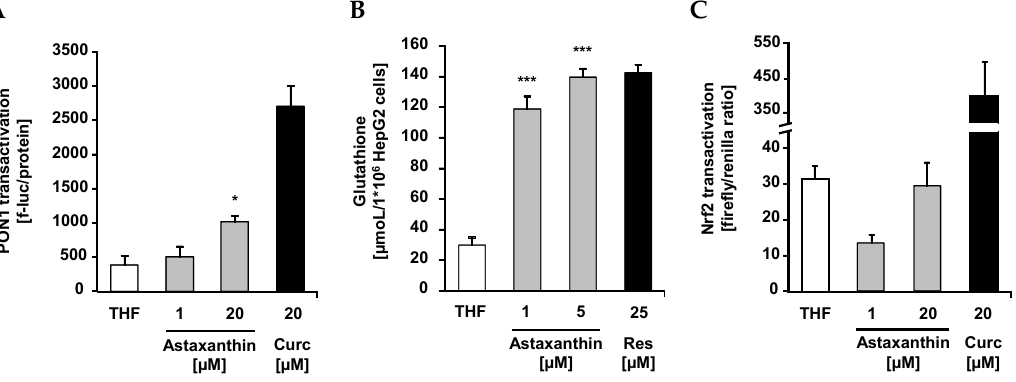
Figure 4. Effects of astaxanthin on transactivation of paraoxonase-1 (PON1) ( A ), cellular glutathione (GSH) levels ( B ) and transactivation of Nrf2 ( C ) in cultured hepatocytes. ( A ) PON1-Huh7 cells were seeded at a density of 0.15 × 10 6 cells/well into 24 well plates and incubated for 24 h at 37 °C. Cells were treated with 1 and 20 μ M astaxanthin. PON1 transactivation was measured after 48 h incubation of the cells with synthetic astaxanthin. Curcumin (Curc; 20 μ M) was used as a positive control; ( B ) HepG2 cells were seeded at a density of 0.15 × 10 6 cells/well into 24-well plates and incubated for 24 h. Cells were treated with 1 and 5 μ M astaxanthin and incubated for an additional 24 h. Resveratrol (Res; 25 μ M) was used as a positive control; ( C ) Huh7 cells were seeded at a density of 0.15 × 10 6 cells/well into 24 well plates and incubated for 24 h at 37 °C. Cells were transfected for 24 h. Nrf2 transactivation was measured after 24 h incubation of the cells with 1 and 20 μ M astaxanthin. Curcumin (Curc; 20 μ M) was used as a positive control. All values are means + SEM (two independent experiments performed in triplicate), statistical significant differences between THF-control cells and astaxanthin supplemented cells are indicated as * p < 0.05, *** p < 0.001; one-way ANOVA LSD (Figure 4A) and Dunnett-T (Figure 4B).